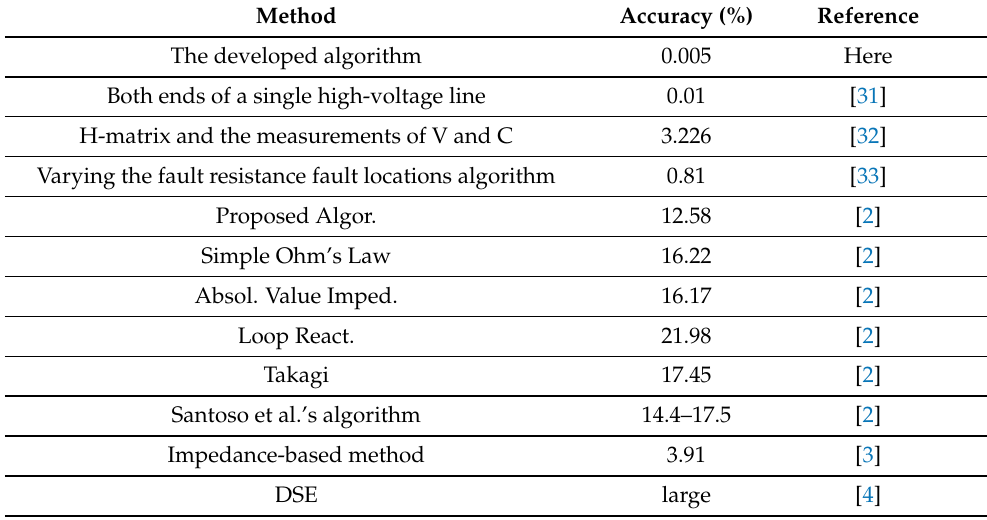
Table 4. Comparison of fault location accuracy methods. DSE—distribution state estimation algo- rithm. SMT—synchronized measurement